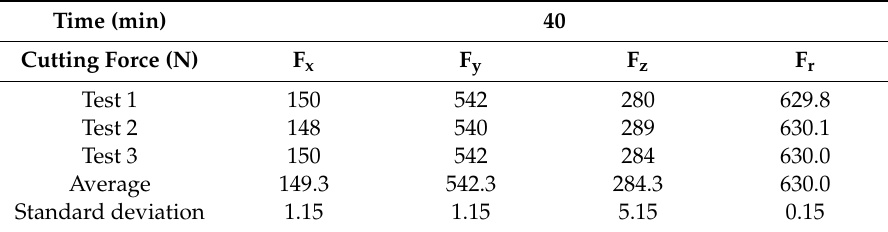
Table 6. The cutting force at the 40 min of the experiment for Tool